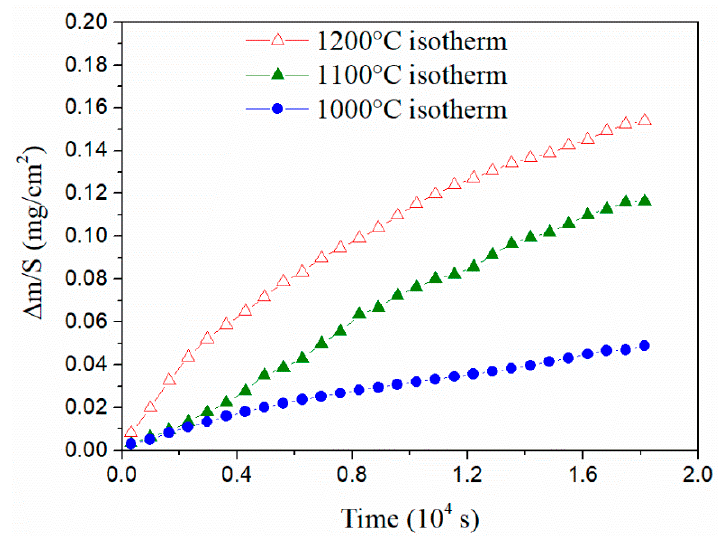
Figure 7. Evolution of the weight gain of the SiC-IrSi 3 composite material obtained in an isothermal condition at different temperatures in an oxidizing atmosphere (N 2 /O 2 ratio is 4:1).